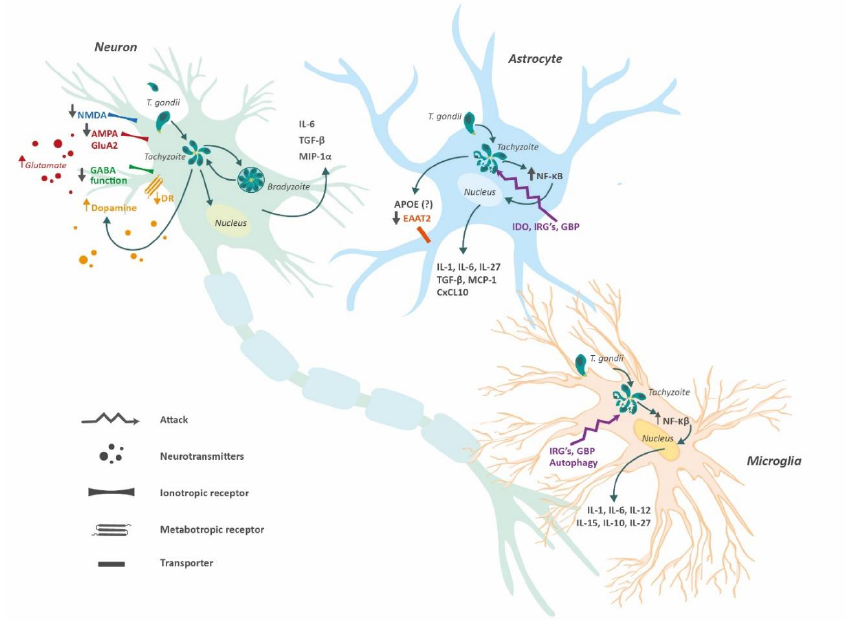
Figure 2. Central nervous system cells and Toxoplasma gondii . Tachyzoites from T. gondii can enter astrocytes, microglia and neurons. The presence of T. gondii induces functional changes in these cells which promote the release of anti- and pro-inflammatory cytokines, and alter both gliotransmission and neurotransmission. Neurons lack an e ff ective defense system against the parasite, therefore, cysts with bradyzoites can form perpetuating the infection. In contrast, astrocytes and microglia possess di ff erent mechanisms to protect against the presence of tachyzoites. Abbreviations: α -amino-3-hydroxy-5-methyl-4-isoxazolepropionic acid receptor (AMPA); Apolipoprotein E (APOE); C-X-C motif chemokine 10 (CXCL10); excitatory amino acid transporter (EAAT); γ -aminobutyric acid (GABA); guanylate-binding protein (GBP); immunity-related GTPases (IRG´s); indoleamine 2,3-dioxygenase (INO); Interleukin (IL); monocyte chemoattractant protein 1 (MCP-1); Macrophage Inflammatory Proteins 1 alpha (MIP-1 α ); nuclear factor kappa-light-chain-enhancer of activated B cells (NF- κ B); transforming growth factor beta (TGF- β